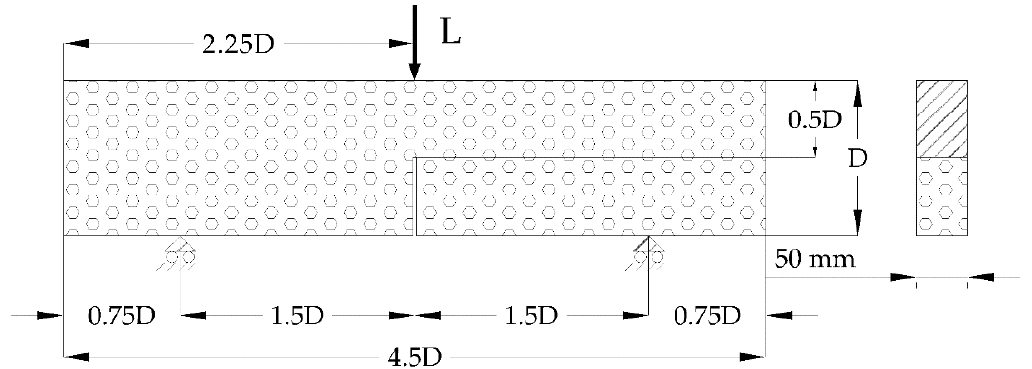
Figure 3. Specimen dimensional proportions and testing support and loading setup. Table 2. Size and number of valid testing specimens.